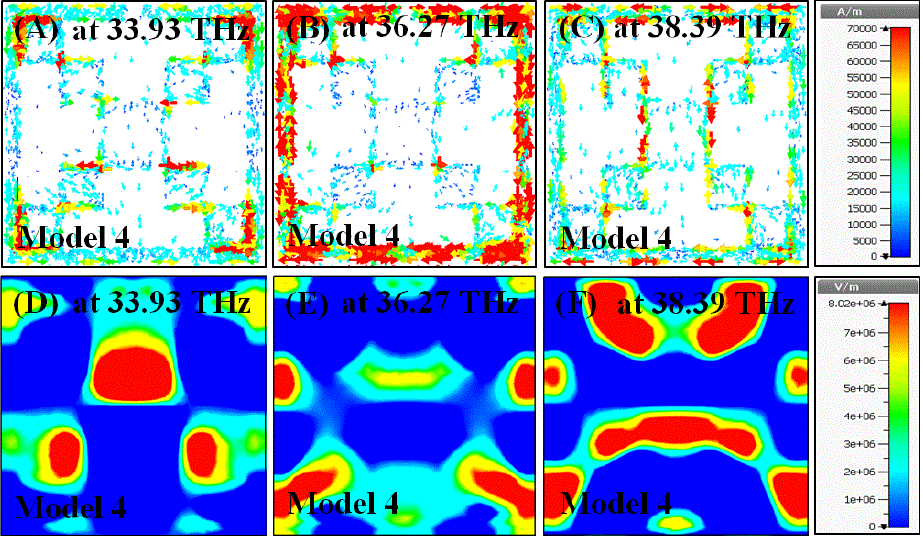
Figure 11. Color map of the current and electric field distributions of proposed metamaterial structure surface current and electric field at three different frequencies.